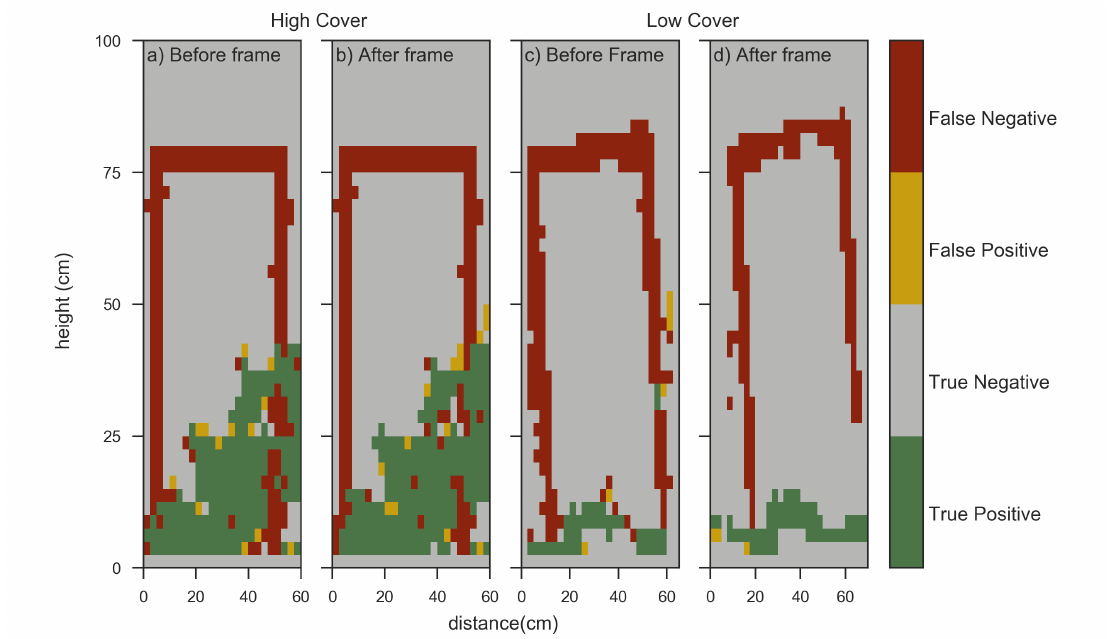
Figure 3. Visualisations of the agreement between point cloud data captured at high cover and low cover plots using TLS workflows. The differences are shown between point clouds with and without the frame in place: ( a , c ) the comparison to the point cloud captured before the frame was introduced; and ( b , d ) the comparison after to the point cloud captured after the frame was removed.